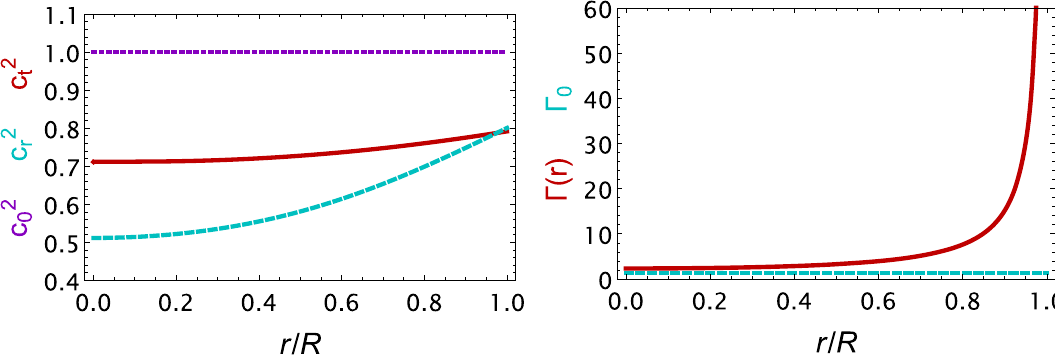
Fig. 2 Anisotropic DE stars within complexity factor: Speed of sounds (left panel) and relativistic adiabatic index (right panel) versus radial coordinate throughout the star